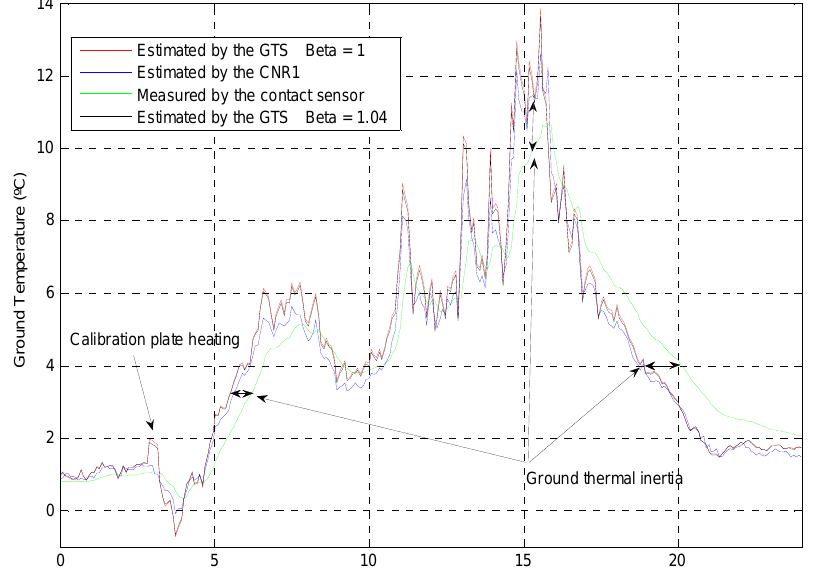
Figure 10. Ground temperature estimated by the GTS in comparison with calibrated CNR1 net radiometer and contact RTD sensor (Pt100) for the 25th of January.